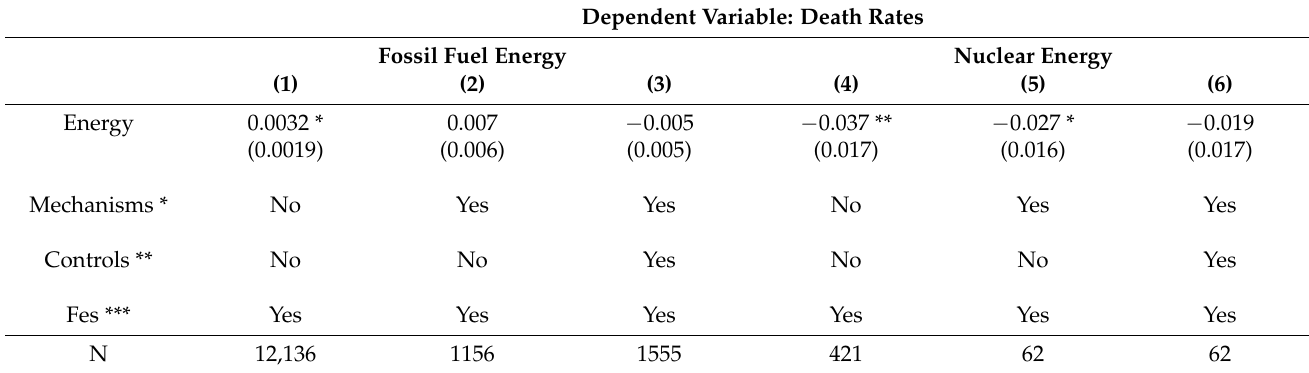
Table 2. Preliminary analysis with and without mechanisms and control variables to verify the mechanism approach effectiveness: county-level.